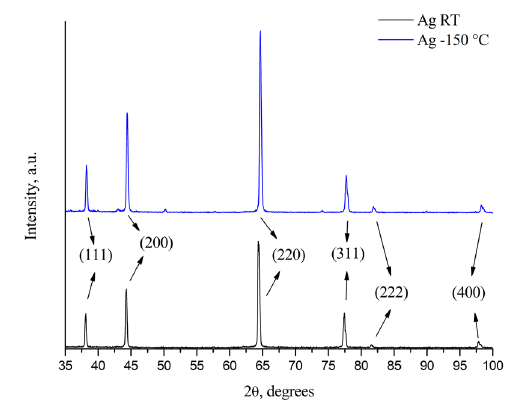
Figure 8. XRD silver rolled at RT and CT.